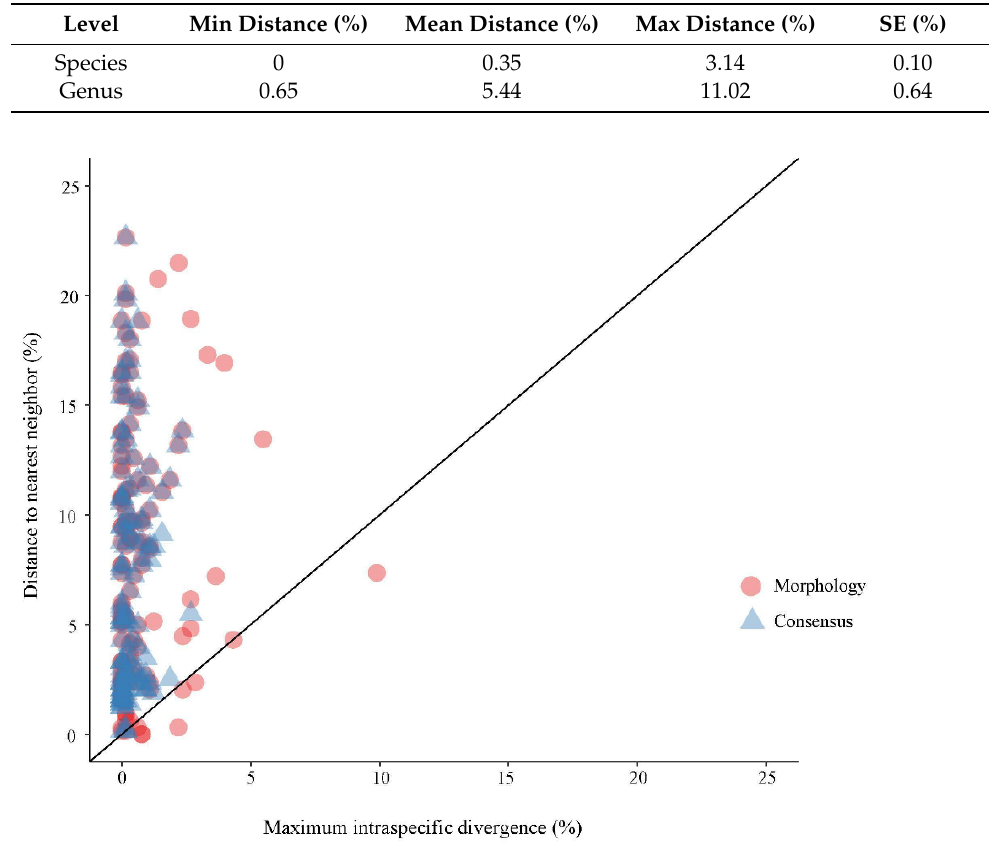
Table 1. Summary of K2P distances within species and genus levels of fishes.